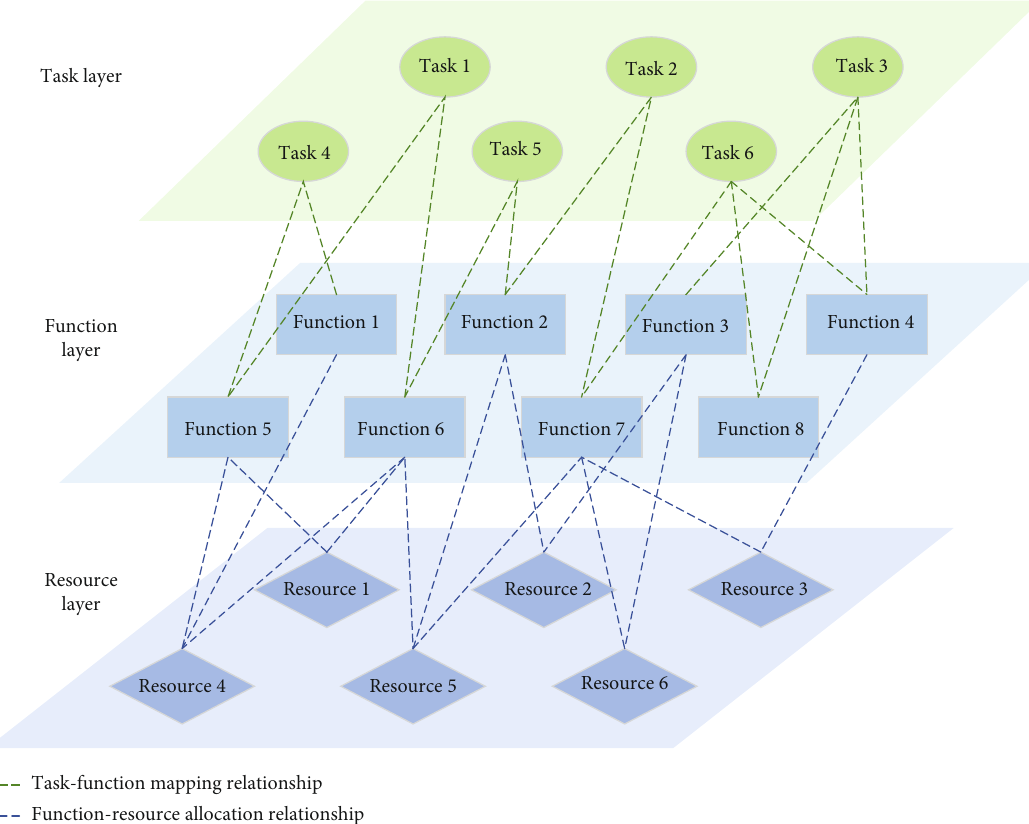
Figure 1: The hierarchy architecture of IMA